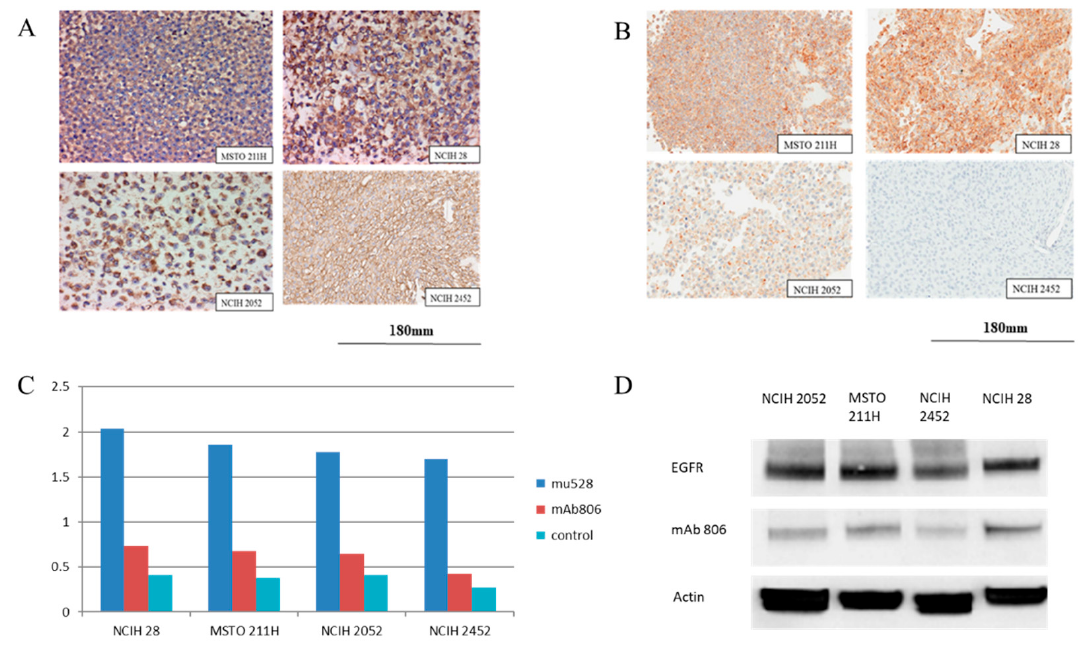
Figure 1. ( A ) Presence of epidermal growth factor receptor (EGFR) immunoreactivity in all 4 mesothelioma cell lines (MSTO-211H, NCIH-28, NCIH-2052 and NCIH-2452). ( B ) Three out of 4 malignant mesothelioma (MM) cell lines (NCIH-28, NCIH-2052 and MSTO-211H) demonstrated mAb806 epitope immunoreactivity. Expression of the mAb806 epitope on immunohistochemical staining (IHC) was considered to be positive if greater or equal to 5% of the cells were stained. ( C ) Comparative bar graphs demonstrating the mean log shift (from triplicates) in fluorescence from the control for each of the 4 mesothelioma cell lines illustrating the relative expression of EGFR (mu528) (dark blue), mAb806 (red) and immunoglobulin G(IgG) idiotype control (light blue). ( D ) Western blot analysis of EGFR and mAb806.